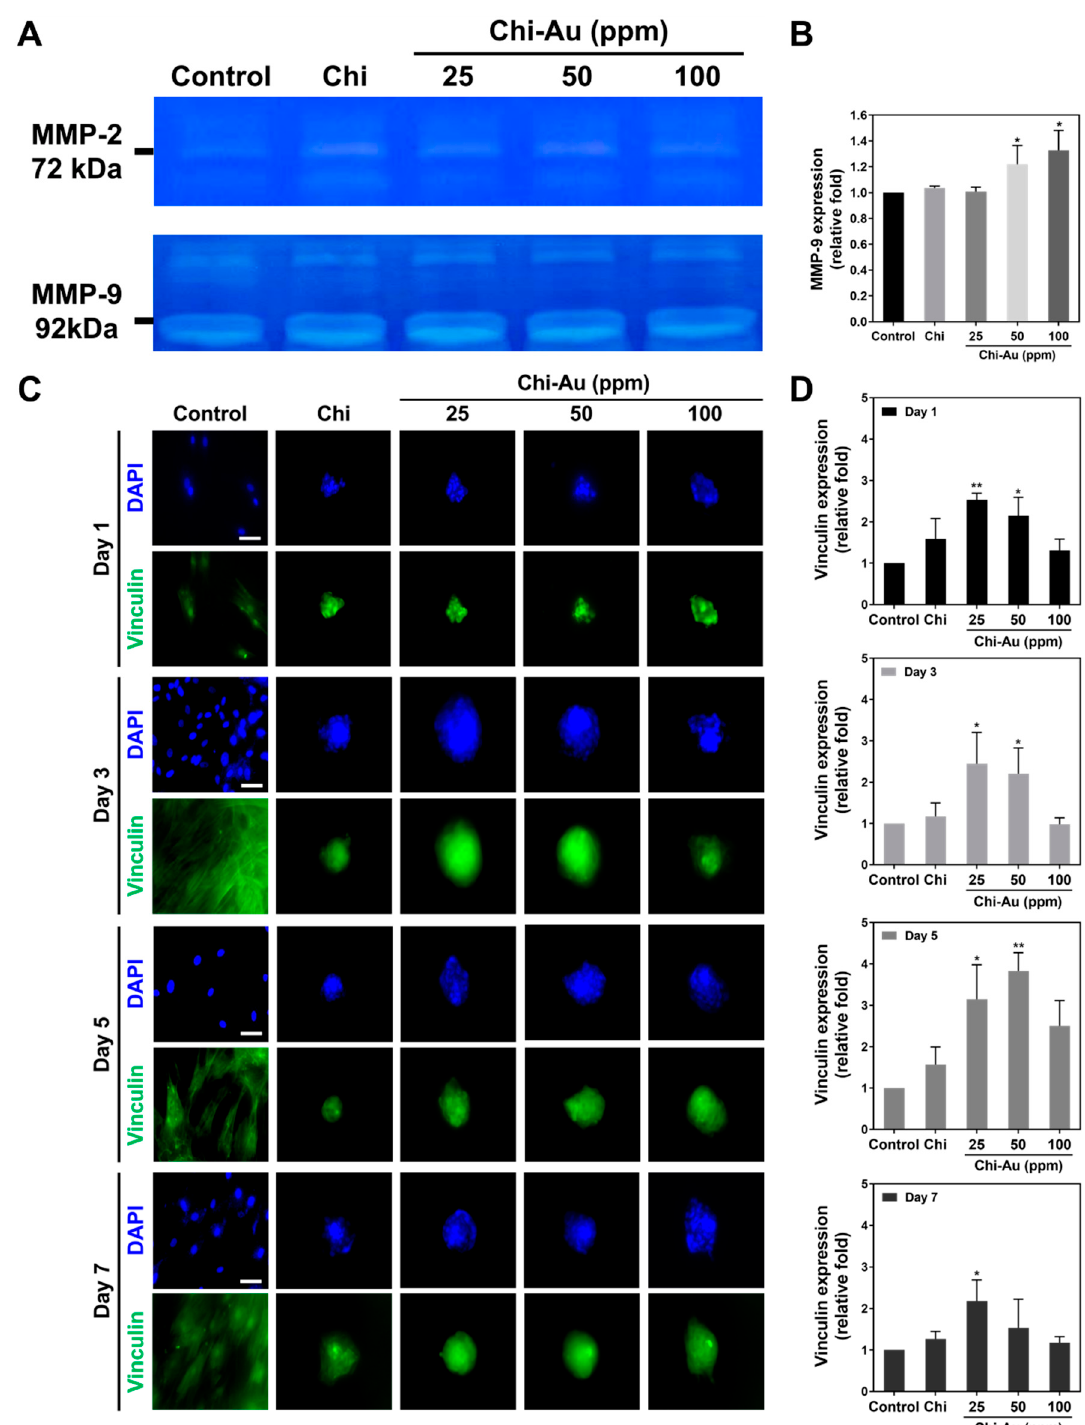
Figure 4. Expression of MMP-2/9 protein and vinculin in MSCs incubated with Chi–Au nanocom- posites. ( A ) The MMP-2/9 protein expressions at 48 h are shown. ( B ) The MMP-9 protein expression was semi-quantified. The MMP-9 protein expression was significantly increased in the Chi–Au 50 and 100 ppm groups. ( C ) The images of vinculin expression in MSCs were demonstrated by immunofluorescence staining at 1, 3, 5, and 7 days. Scale bars measure 20 µ m. ( D ) The expression of vinculin in MSCs at various time points was semi-quantified according to expression intensity. The vinculin expression was significantly higher when treated with Chi–Au 50 ppm at 5 days. Data are displayed as mean ± SD ( n = 3). * p < 0.05, ** p < 0.01: compared with the control